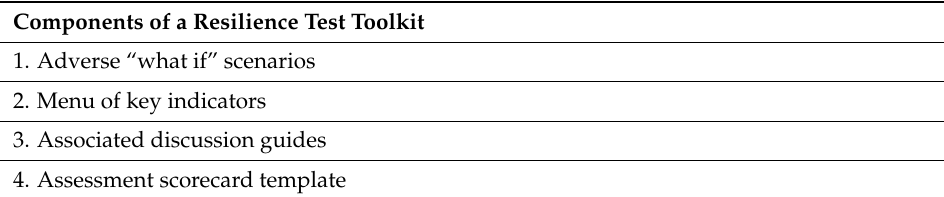
Table 1. Four components of the resilience test